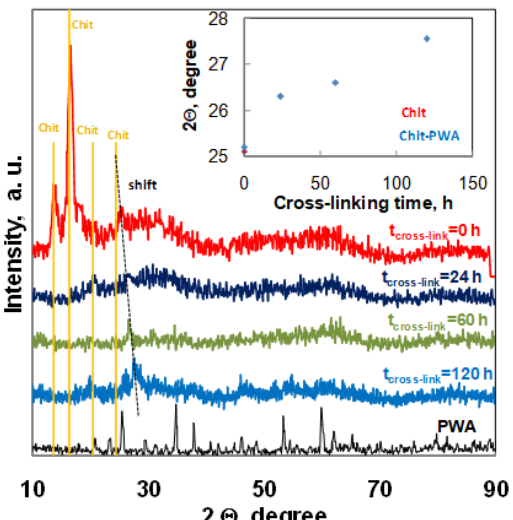
Figure 5. XRD spectra recorded for composite Chit / PWA flat structures prepared according to the BIG method at 1% wt / v Chit and different post crosslinking times.